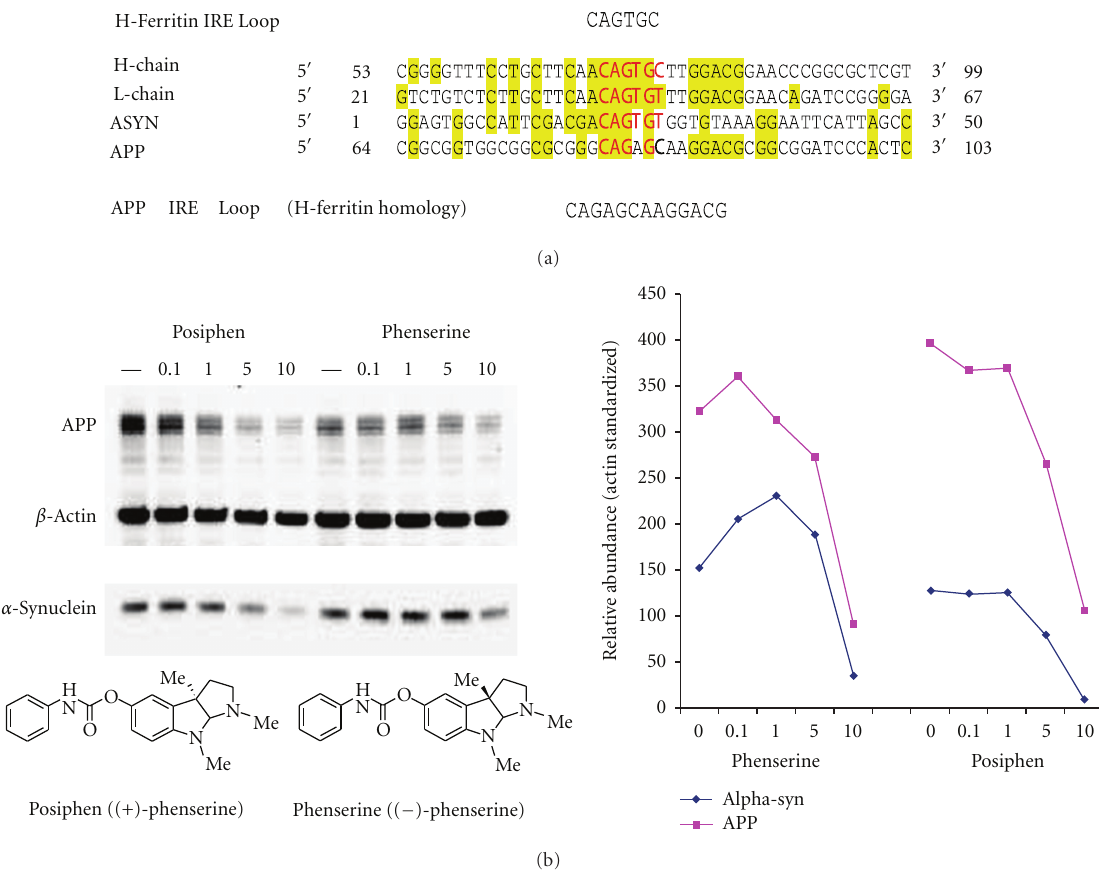
Figure 2: Posiphen and phenserine decrease both APP and α - synuclein levels dose-dependently in dopaminergic SH-SY5Y cells. Panel A: the 5 (cid:2) UTRs of both the APP and SNCA genes are 50% homologous with the IRE H-ferritin mRNA. Panel B: SH-SY5Y cells were treated with concentrations ranging from 0 to 10 μ M phenserine and posiphen for 48h. Harvested cell lysates were prepared. Quantitative Western Blotting established the anti- α - syn e ffi cacy of posiphen and phenserine (IC 50 < 5 μ M); after standardization for β -actin (Densitometry of multiple lanes ( n = 8) by ImageQuant). Cell viability was una ff ected (measured by standardized ATP levels/cell (Tm (Cell-Titer-glo, Promega,